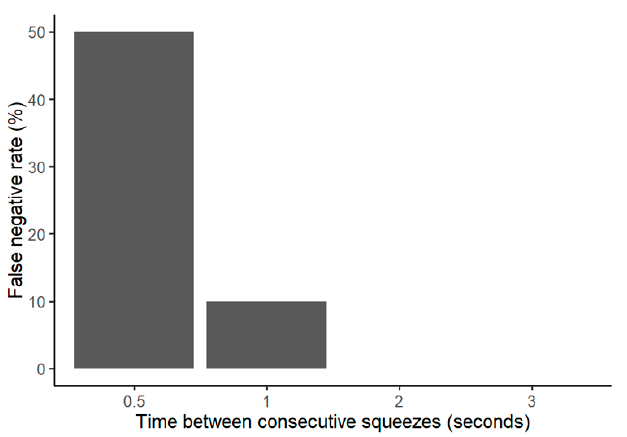
Figure 5. False negative test with two consecutive squeezes. For 2 and 3 s between squeezes, the false negative rate is at 0%.